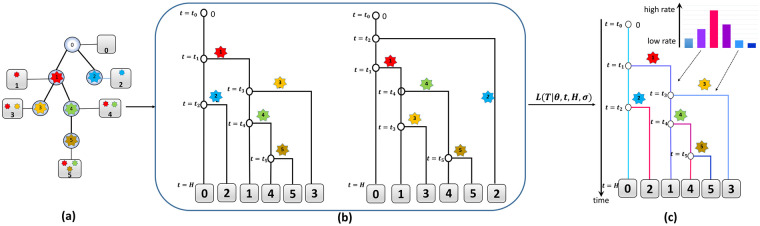
Algorithm for the maximum likelihood inference of mutability landscape.(a) Mutation tree T. (b) Two binary phylogenies B1(T) and B2(T) corresponding to two different orders of events t0 < t1 < t3 < t2 < t4 < t5 < H and t0 < t2 < t1 < t4 < t3 < t5 < H. Each internal vertex is labeled with its time stamp, thus resulting in the same mutation tree T. Each branch (ti, tj) is labeled by the leaf-subclone on the vertical line through its endpoint tj. All leaves have the sampling time stamp t = H. (c) Maximum Likelihood phylogeny and mutability landscape. Mutation rates along the branches corresponding to different subclones are highlighted in different colors.